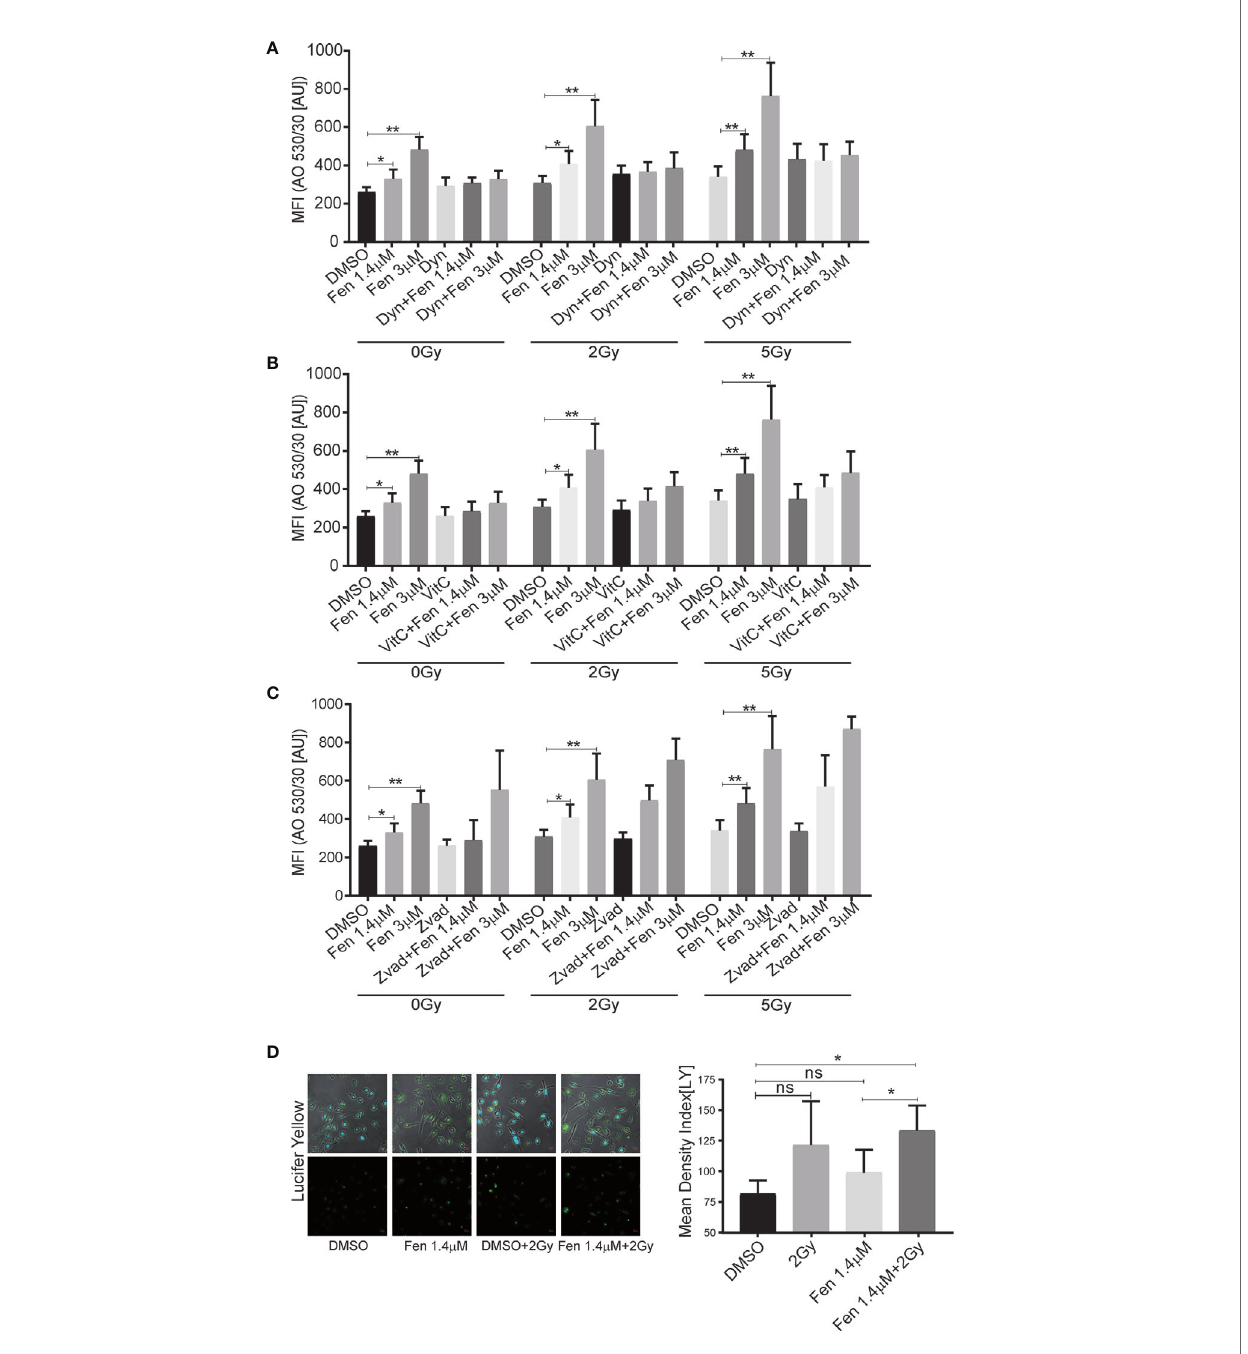
FIGURE 3 | The combinatorial treatment of fenretinide and radiation therapy leads to an enhanced uptake of phase lucent dyes. (A – C) Mean fl uorescence index analysis of fl ow cytometry data of fenretinide (1.4/3 µM) and IR (2 Gy/5 Gy) treated Rh4 cells, co-treated with either dynasore (30 µM) (A) , Vitamin C (50 µM) (B) or Z-vad (100 µM) (C) and stained with acridine orange (2.7 µM) using two different bandpass fi lters, here 530/30 (Bandpass fi lter 670/30 Supplementary Figures 1A – C ) *p</=0.05, **p</=0.01. (D) Fluorescence microscopy images of Rh4 cells left untreated or treated with fenretinide (1.4 µM), IR (5 Gy) or the combination thereof and stained with Lucifer Yellow (820 µM). Quanti fi cation of the relative mean density index was performed with Fiji software: Total integrated density value of an image was divided by the number of cells. ns: p>0.05, **p</=0.01. Supplementary Figure 1 : The combinatorial treatment of fenretinide and IR therapy leads to an enhanced uptake of phase lucent dyes. (A – C) Mean fl uorescence index analysis of fl ow cytometry data of fenretinide (1.4/3 µM) and IR (2Gy/5Gy) treated Rh4 cells in presence or absence of dynasore (30 µM) (A) , Vitamin C (50 µM) (B) or Z-vad (100 µM) (C) and stained with acridine orange (2.7 µM) using two different bandpass fi lters, here 670/30 (Bandpass fi lter 530/30 A – C ).